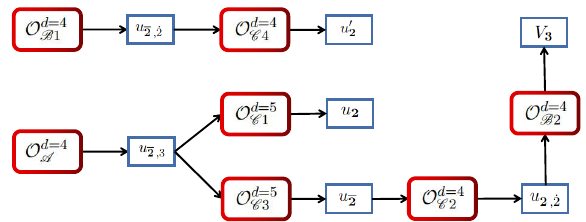
Figure 1 . The generation chains of all additional Higgs VEVs through the gauge-invariant operators composed by SU(7) Higgs